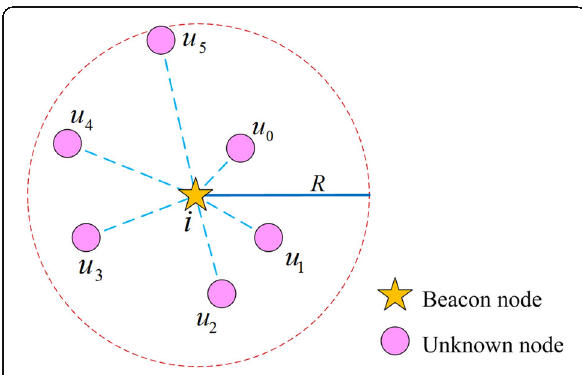
Fig. 2 Distribution diagram of unknown nodes within the communication radius of beacon